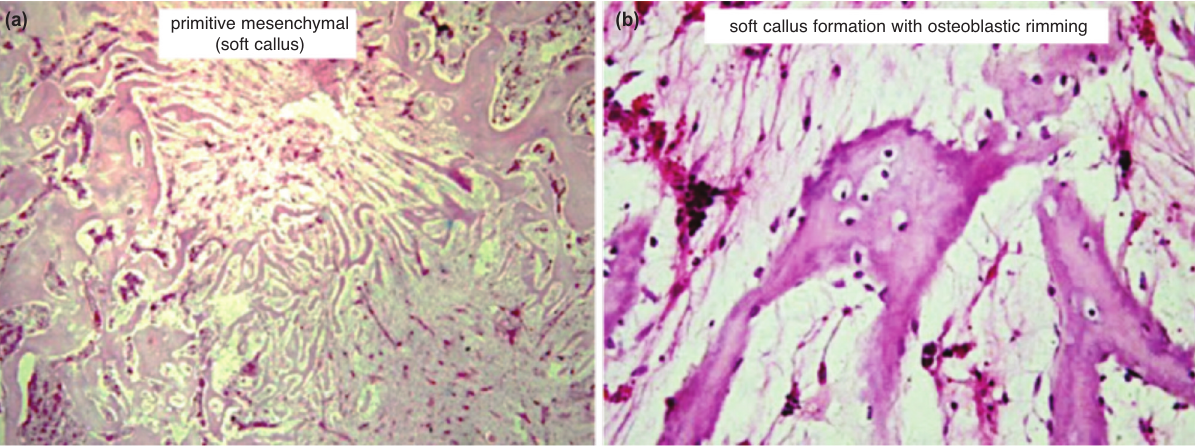
Histology features of Group O2 (HA:PMMA ratio 2:1); (a) The space was entirely filled with callus formation (5X, HE). Fig. 3: (b) The callus showed calcified trabecule, minimal remnant of HA material (20X, HE).